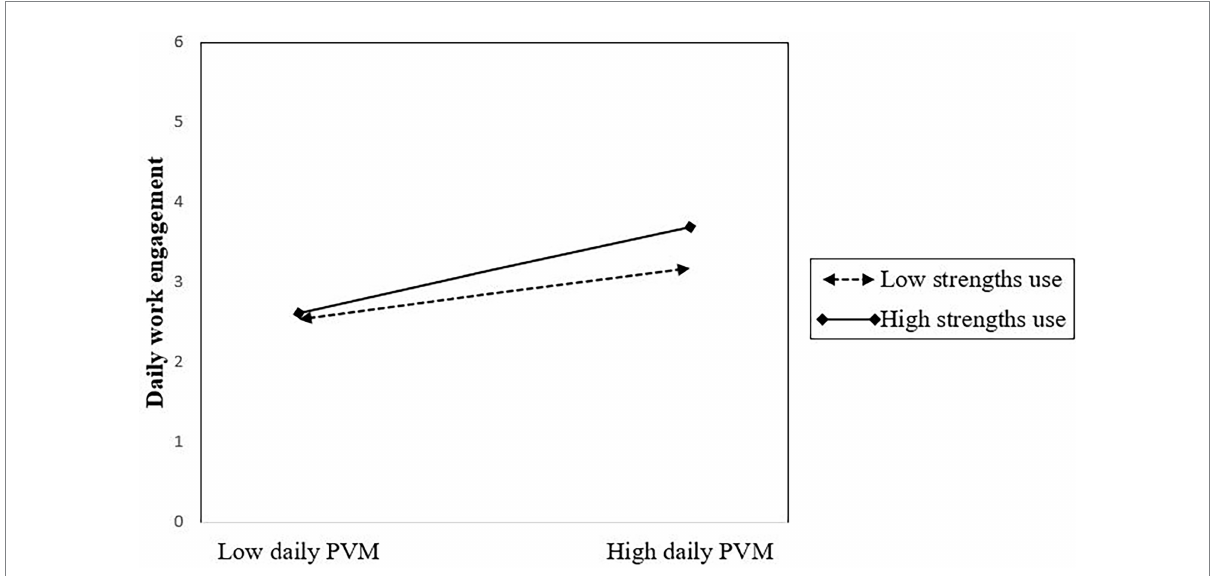
FIGURE 2 The cross-level interaction between general SU and daily PVM in predicting daily